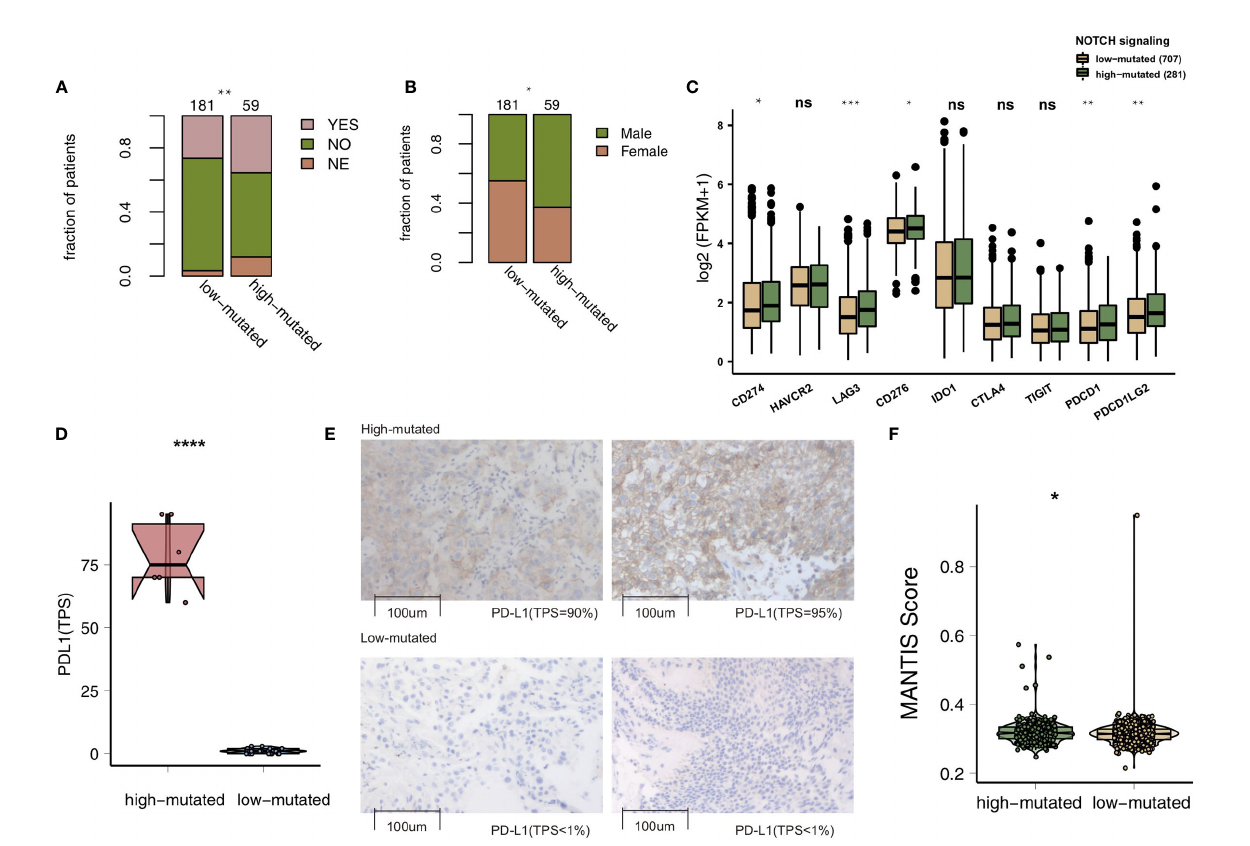
FIGURE 3 | (A) . Bar plot showing the proportion of patients in the MSKCC cohort who experienced durable clinical bene fi ts. (B) Bar plot showing the proportion of patients in the MSKCC cohort according to sex. The range of p-values is presented by the asterisks above the bar plot (*P < 0.05; **P < 0.01; ***P < 0.001; ****P < 0.0001; Fisher ’ s exact test). (C) Box plots comparing the expression levels of immune checkpoint molecules between the high-mutated and low-mutated NOTCH groups. The range of p-values is presented by the asterisks above each box plot (*P < 0.05; **P < 0.01; ***P < 0.001; ****P < 0.0001; Mann-Whitney U test). (D) Box plots comparing the expression levels of PD-L1 (TPS) between the high-mutated and low-mutated NOTCH groups in the Local cohort (****P < 0.0001; Mann-Whitney U test). (E) Typical cases of the PD-L1 (TPS) level in the high- (2 samples) and low-mutated (2 samples) groups in the Local cohort. (F) . Violin plots showing the MANTIS score. The range of p-values is presented by the asterisks above the violin plot (*P < 0.05; **P < 0.01; ***P < 0.001; ****P < 0.0001; Mann-Whitney U test). TPS, tumor proportion score; NSCLC, non-small cell lung cancer; TCGA, The Cancer Genome Atlas; PD-L1, programmed cell death-ligand 1. NS, not signi fi